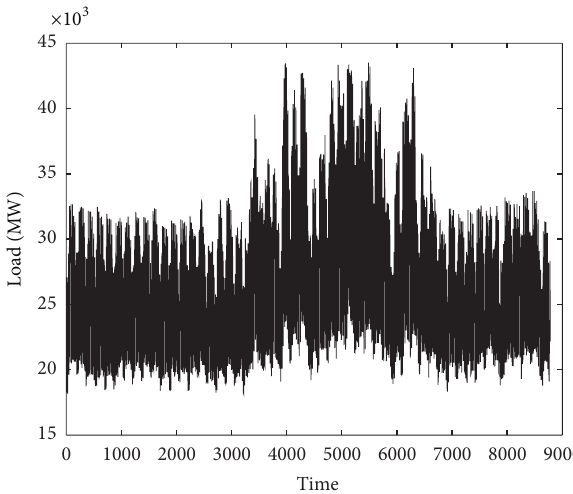
Figure 2: Hourly load data of California energy market in the year 2000.